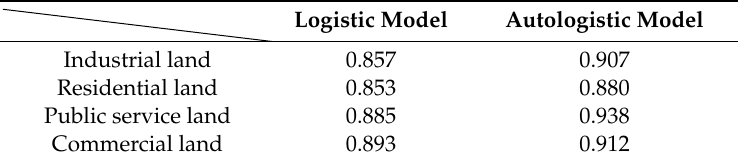
Table 6. Comparison of the fitting e ff ects of the traditional logistic model and autologistic model.